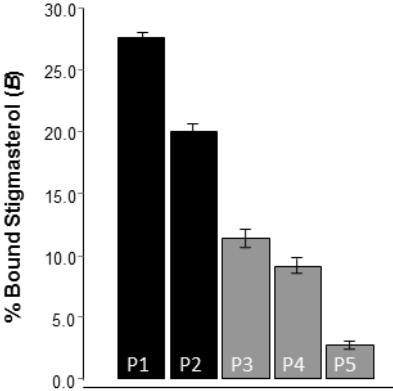
Figure 2. Stigmasterol binding evaluation for the imprinted (P1 and P2, black) and non-imprinted polymers (P3–P5, grey) under static batch binding conditions. Binding conditions are described in the Materials and Methods. The error bars indicate the standard error of the mean.